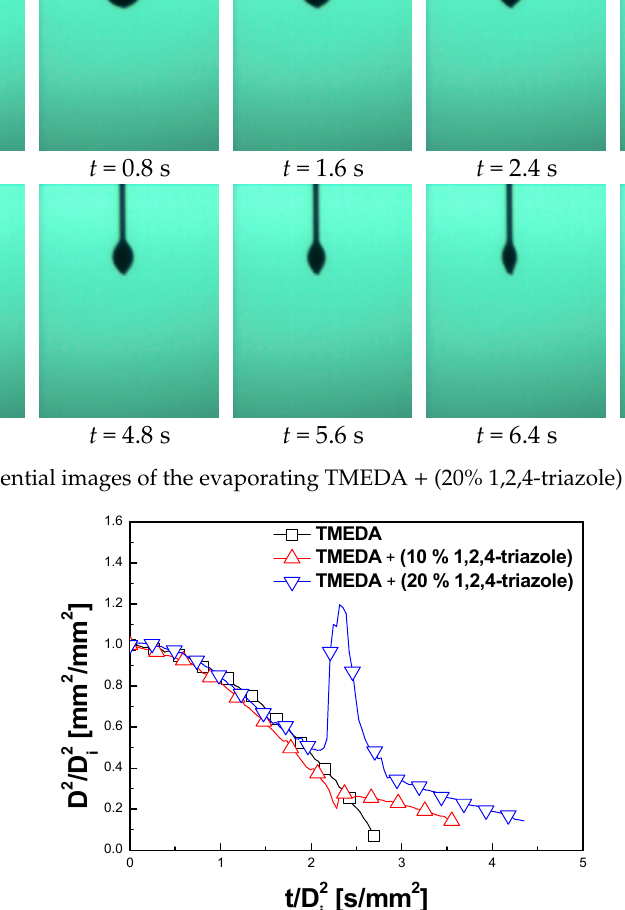
Figure 12. Normalized variation of evaporating TMEDA-based fuel droplet diameter squared with normalized time at 500 °C.